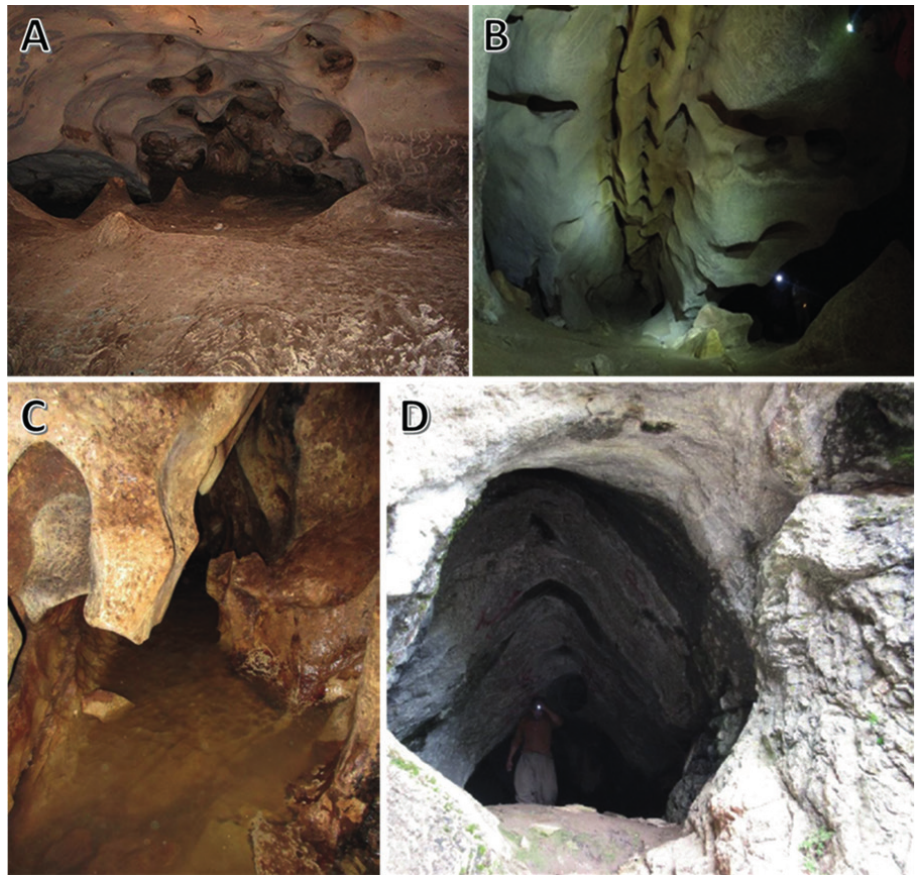
Figure 2. Four caves of Kurdistan with the highest priority for conservation programs: A Karaftu B Kamtaran C Darvish Ouliya D Kouna